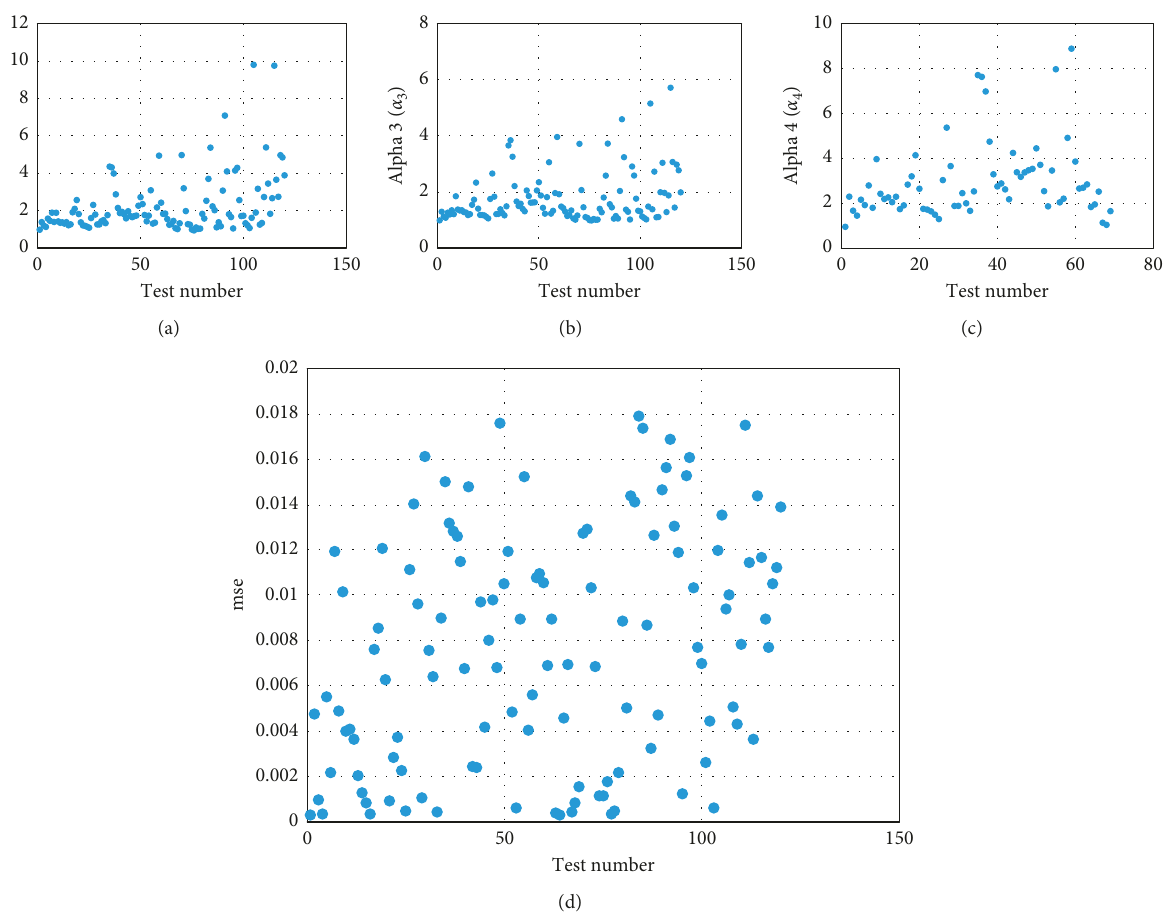
Figure 13: All (a) alpha ( α ) and (b) mse coefficients calculated by using the model proposed by Polito et al.